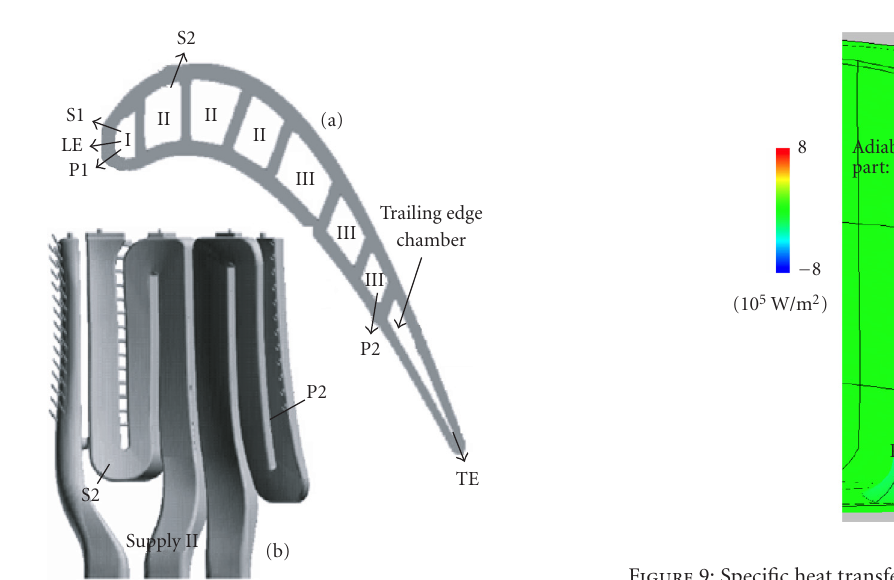
Figure 9: Specific heat transfer distribution at the leading edge.